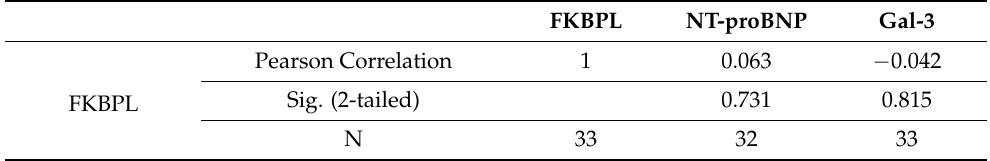
Table 3. Pearson’s correlations between FKBPL, NT-proBNP and